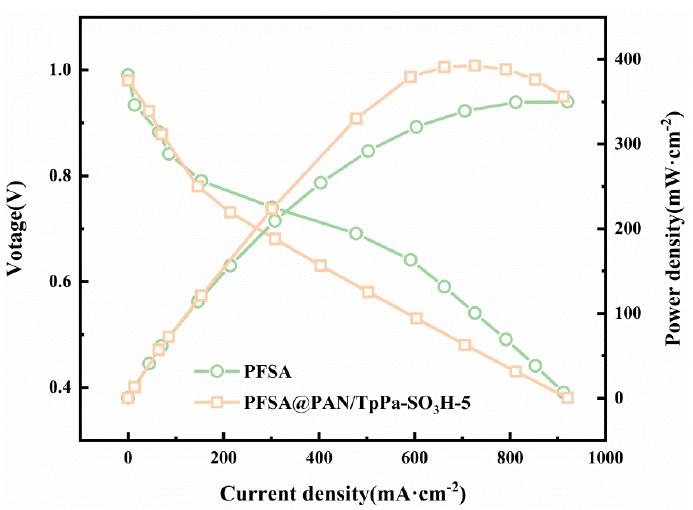
Figure 10. FuelcellperformancecharacterizationofPFSA,andPFSA@PAN/TpPa-SO 3 Hcomposite Figure 10. Fuel cell performance characterization of PFSA, and PFSA@PAN/TpPa ‐ SO 3 H composite membrane.